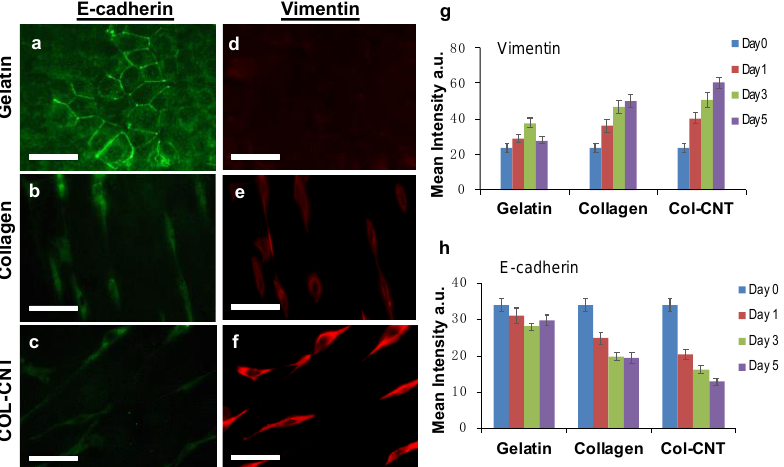
Figure 6. E-cadherin and vimentin expressions in SKOV3 cells cultured on the matrices. ( a – f ) Im- munofluorescent images of SKOV3 cells staining against E-cadherin ( a – c ) and vimentin ( d – f ) on the matrices. Bar size: 193 μm. The cells were cultured on the matrices for 3 days. ( g , h ) ImageJ quantification of the expression levels of vimentin ( g ) and E-cadherin ( h ) in cells grown on the matrices at Day 0, 1, 3, and 5.